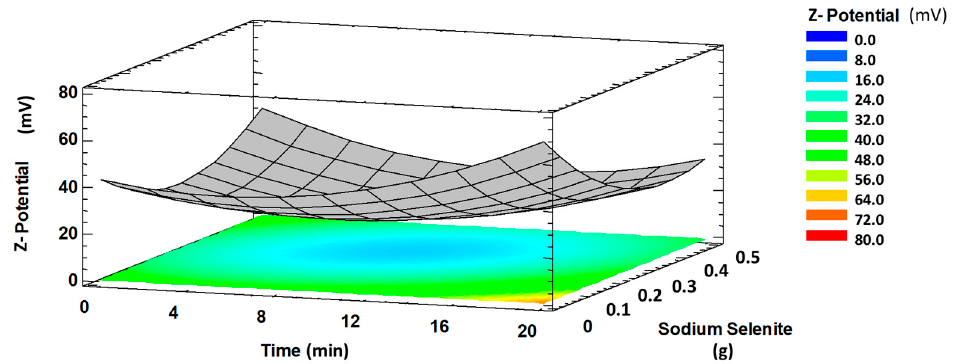
Figure 1. Response surface plot showing significant interaction time (min) versus Na 2 SeO 3 (g) on Z -potential (absolute values).